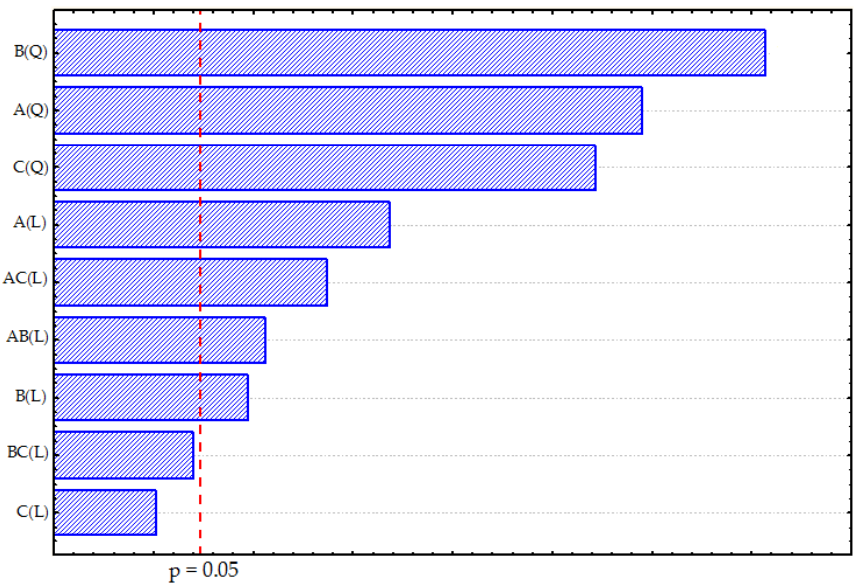
Figure 8. Pareto chart of the standardized effect for the CEC (A, Na 2 CO 3 concentration; B, temperature; C, time, L, linear and Q, quadratic).